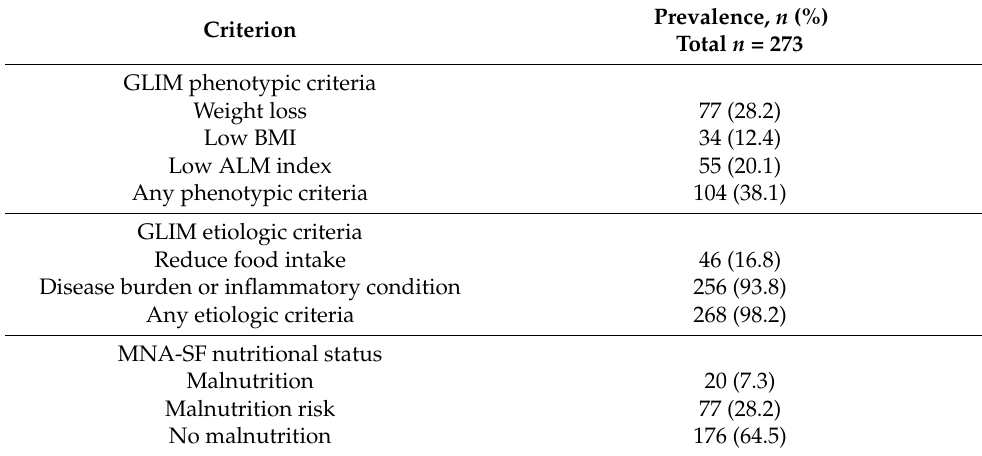
Table 2. Prevalence of the GLIM criteria and impaired nutritional status based on the MNA-SF score.